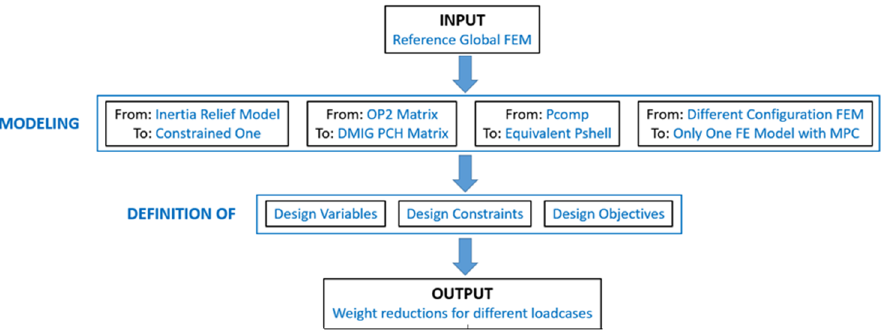
Figure 6. Optistruct optimization